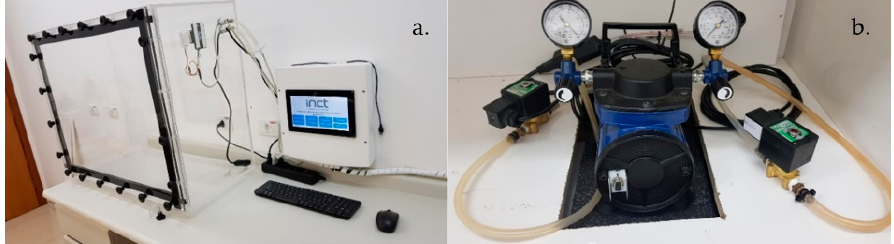
Figure 7. Barometric chamber built for entomology experiments (INCT Semiochemicals in Agricul- ture): ( a ) chamber and electronic control system; ( b ) air pump and proportional solenoid valves.